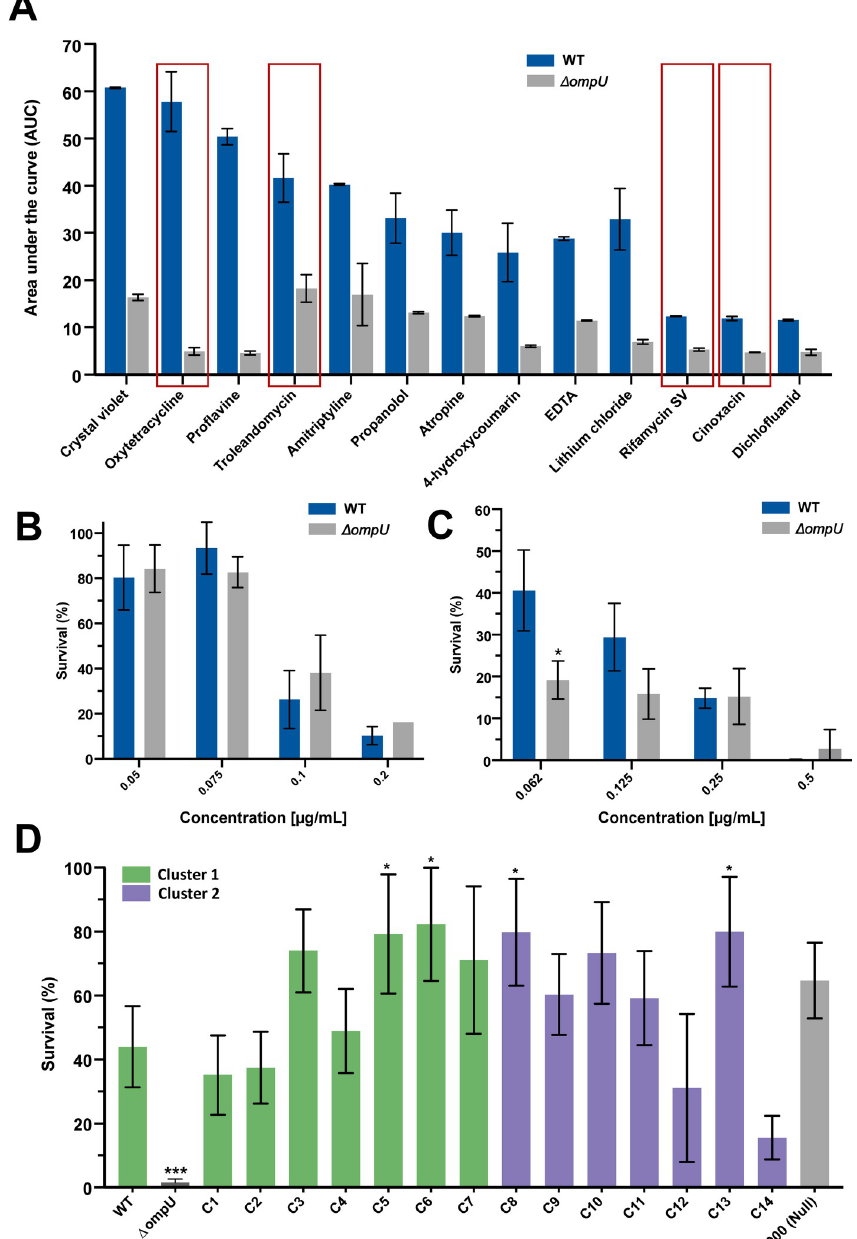
Fig 5. Exploration of novel functions of OmpU. (A) Phenotypic microarrays of V . cholerae WT and Δ ompU strains. Area under the curve (AUC) was calculated to determine the total growth of the strains under exposure to diverse antimicrobial compounds. Only compounds with greater than 2-fold decrease in AUC for Δ ompU strain are shown. Red rectangles indicate antibiotics with clinical relevance. All arrays were performed in duplicate. (B, C) Survival of V . cholerae N16961 and Δ ompU in the presence of varying concentrations of (B) oxytetracycline and (C) cinoxacin. (D) Survival of ompU alleles in 7.5 μ g/mL rifamycin SV. Error bars represent the standard deviation of the mean from at least three ( N � 3) independent replicates. Statistical comparisons were performed using one-way ANOVA analyses followed by a Dunnett’s multiple comparison test. All constructs were compared to the WT unless otherwise stated. * p < 0.05. N � 3, * p <